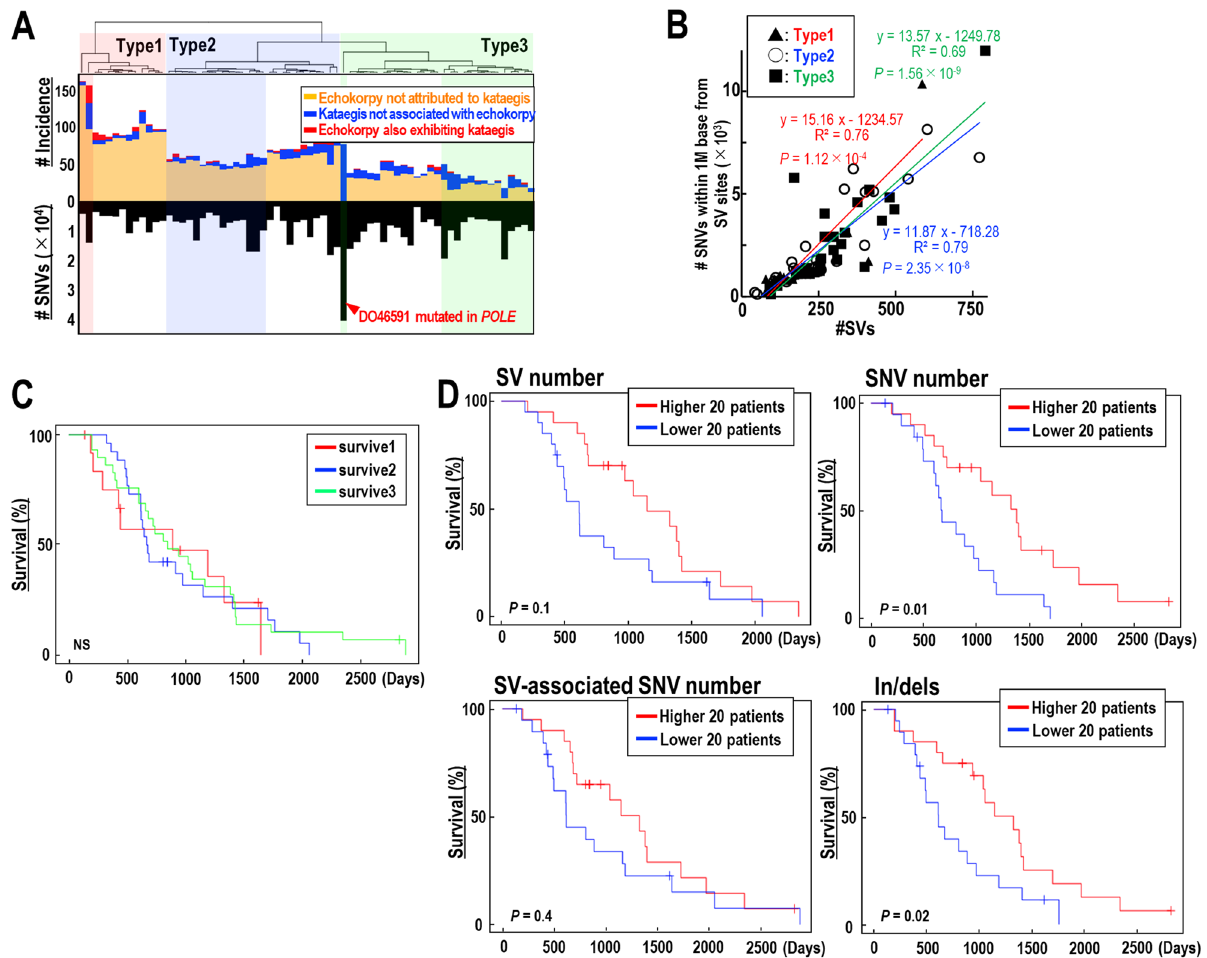
Figure 5. SV/SNV status of ovarian cancer and association with prognosis. ( A ) Classification of ovarian cancers according to echoed SV/SNV induction and kataegis statuses. ( B ) Relationship between SNV counts within 1 Mb of SV sites and the numbers of SVs induced in each type of individual cancers. Statistical analyses by two- tailed t -tests. ( C , D ) Kaplan–Meier analysis of survival in patients with ovarian cancer stratified by classification ( C ) and by the status of SVs, SNVs, SV-associated SNVs, and indels ( D ). Statistical analyses by log-rank